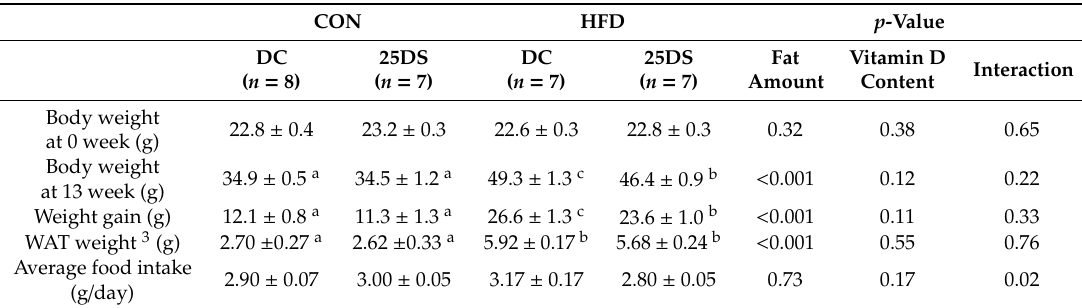
Table 4. Body weight, weight gain, body fat, and food intake of mice in the CON-DC, CON-25DS, HFD-DC, and HFD-25DS groups 1,2 .